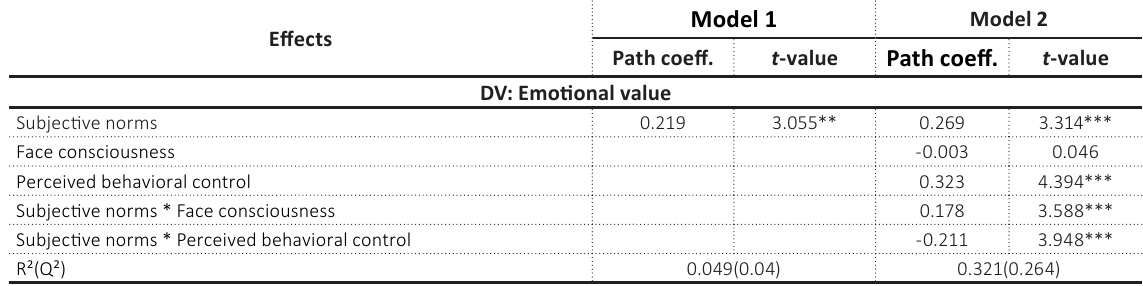
Table 3. PLS results of the structural